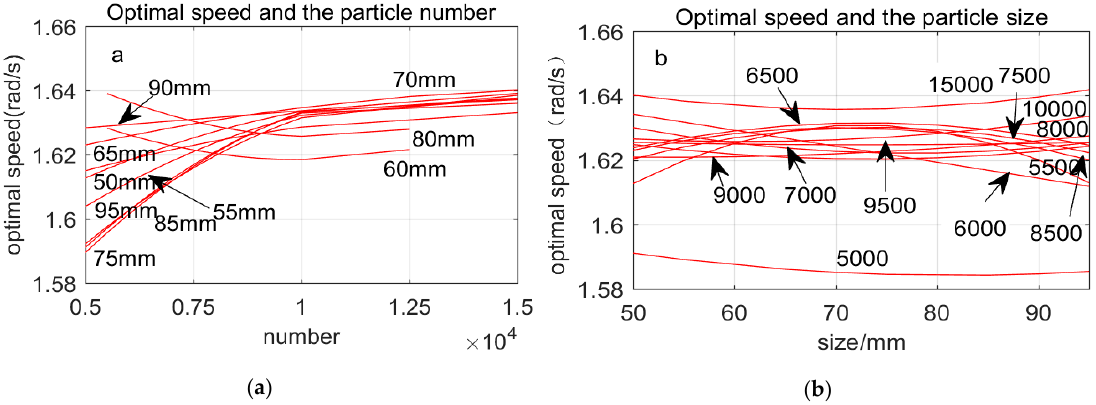
Figure 7. Relationship between the optimal speed and different parameters: ( a ) the optimal speed and the number of particles; ( b ) the optimal speed and particle size.